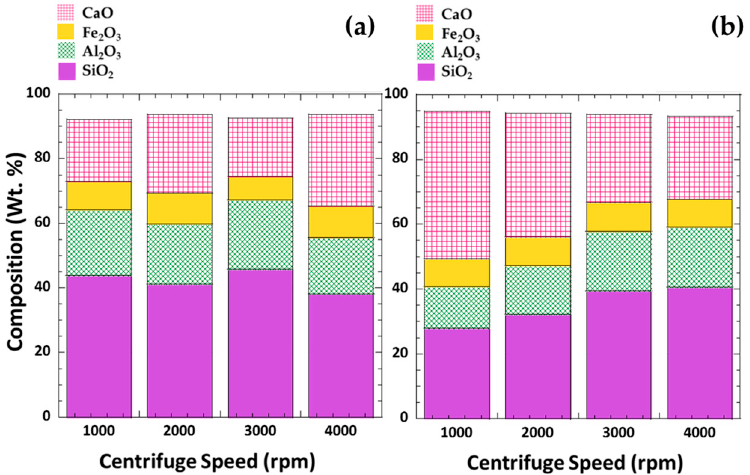
Figure 4. Histograms displaying chemical compositions of cenospheres plotted against centrifugal speed for the centrifugal times of ( a ) 10 min and ( b ) 30 min.